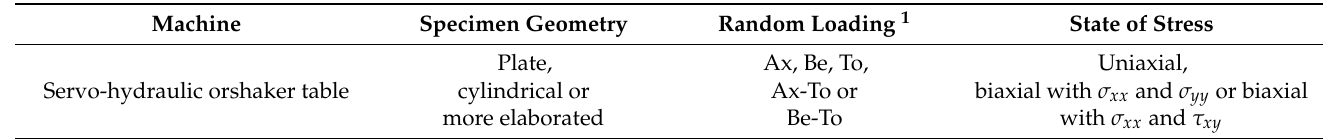
Table 2. Characteristics and specific features used to classify fatigue testing systems. Machine Specimen Geometry Servo-hydraulic orshaker